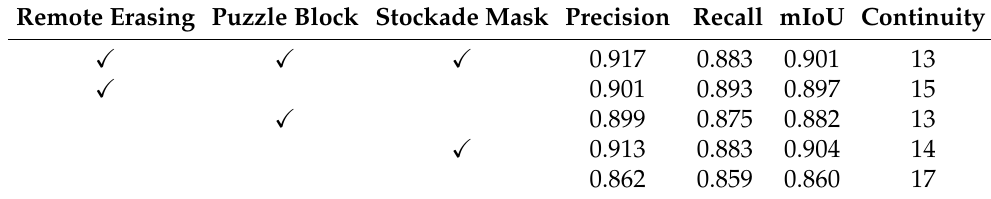
Table 11. Ablation experiment result of different pre-processing